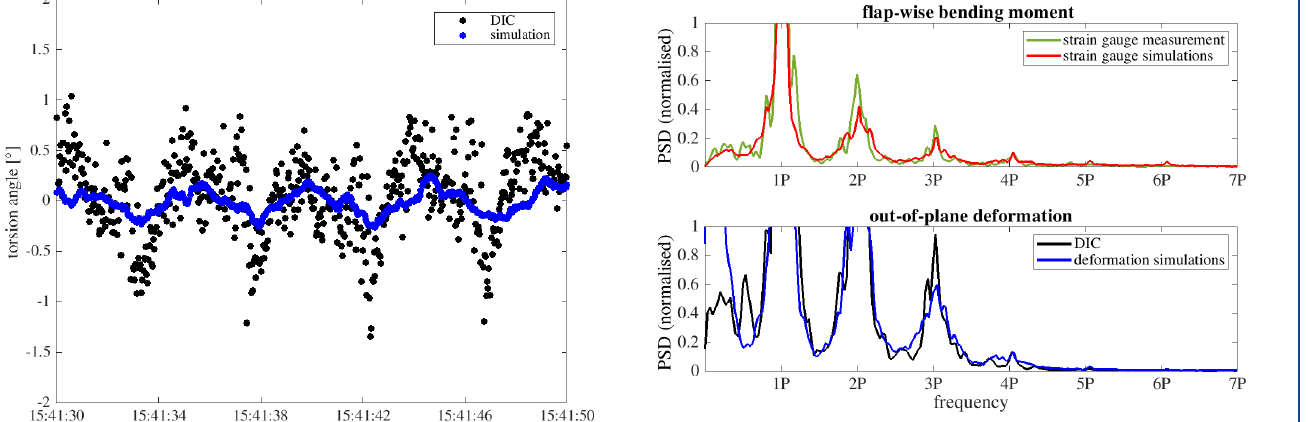
Figure 25. Comparison of torsion angle of blade A of DIC and simulations – short time series.